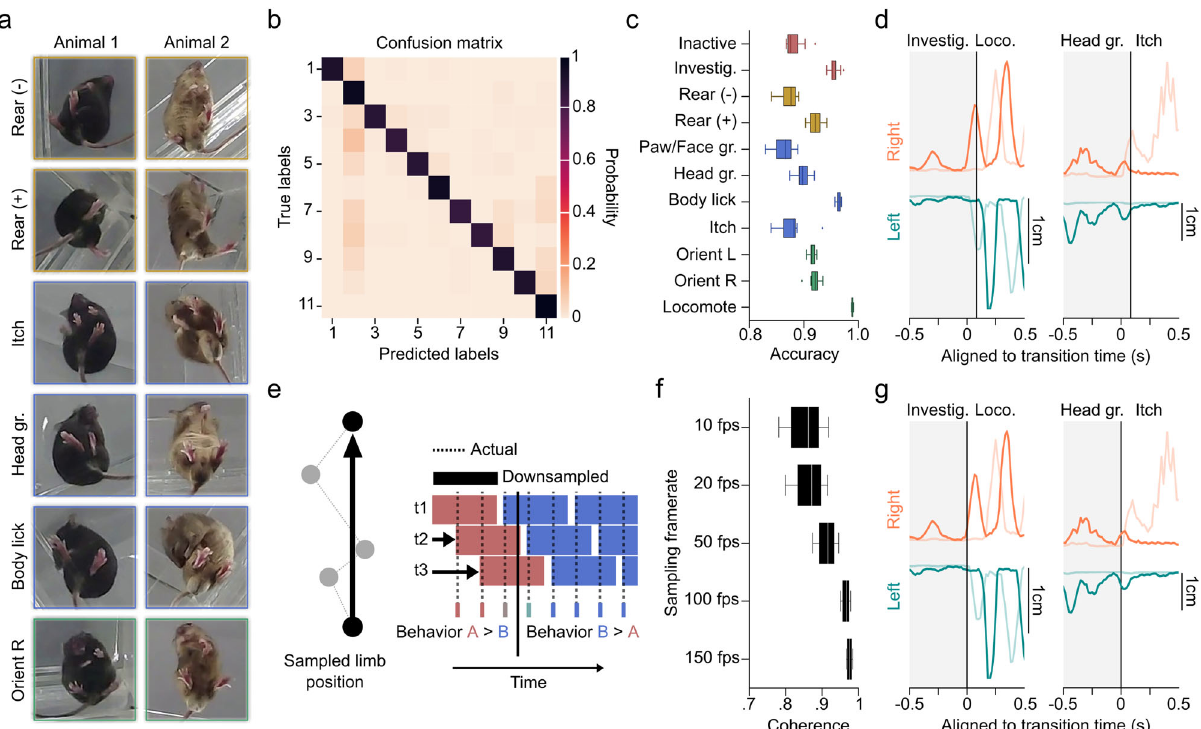
Fig. 2 Performance quanti fi cation across multiple temporal resolutions with novel machine learning algorithms. a Snapshots of a small (Animal 1) and large (Animal 2) mouse, 300 ms into the execution of example behaviors. b Confusion matrix on the 20% held-out data. True positive predictions appear on the diagonal. c 10-fold cross-validation yield high accuracy on shuf fl ed data across behavioral groups (21,600 data points/test), n = 6 animals. Data are presented as mean values± SEM. d Trajectory plots of right (orange) and left (teal) limbs of the fore paw (darker) and hind paw (lighter) demonstrating example transitions from investigate to locomote, and head groom to itch. Vertical lines denote transition time as identi fi ed by basic B-SOiD analysis (10fps). e Schematized example of the potential for prediction noise in pose estimation to override the movement signal at high sampling rates. To overcome this, we executed a frameshift computation to derive high resolution transition times from downsampled, high signal data. f Percent coherence between low frequency and progressively higher resolution frameshift data. A major break occurs under for data under 50 fps, n = 1 animal. Data are presented as mean values ± SEM. g Same trajectories as in ( d ), now incorporating the frameshift algorithm to improve resolution of transitions. Source data are provided as a Source Data fi le for ( b , c , f